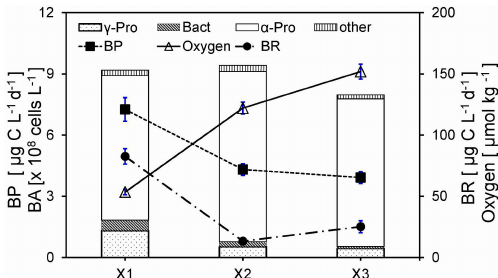
Figure 4. Comparisons of oxygen, bulk bacterial respiration (BR) and production (BP), and bulk bacterial abundances (BAs) of Alphaproteobacteria ( α -Pro), Gammaproteobacteria ( γ -Pro), Bac- teroidetes (Bact), and other bacteria for the bottom waters between stations inside (X1) and outside (X2 and X3) the hypoxic zone dur- ing the 2016 cruise. Bulk bacteria community includes FLB and PAB of < 20µm. Locations of stations X1, X2, and X3 are shown in Fig. 1a. Error bars are the standard